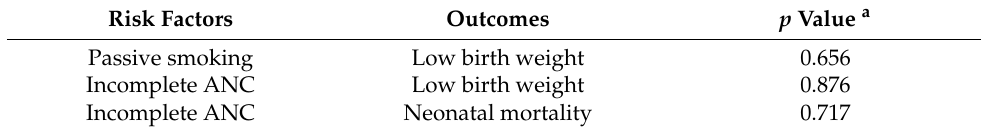
Table 2. Publication bias analysis.